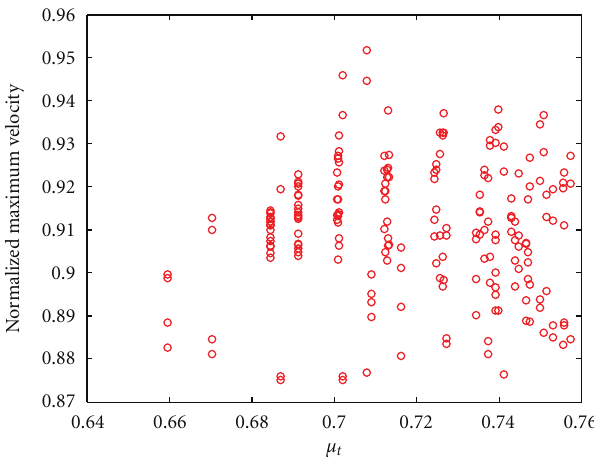
Figure 24: Scatter diagram of manipulability μ t versus velocity along the Z direction (vertical half-plane YZ with X = 0 mm).